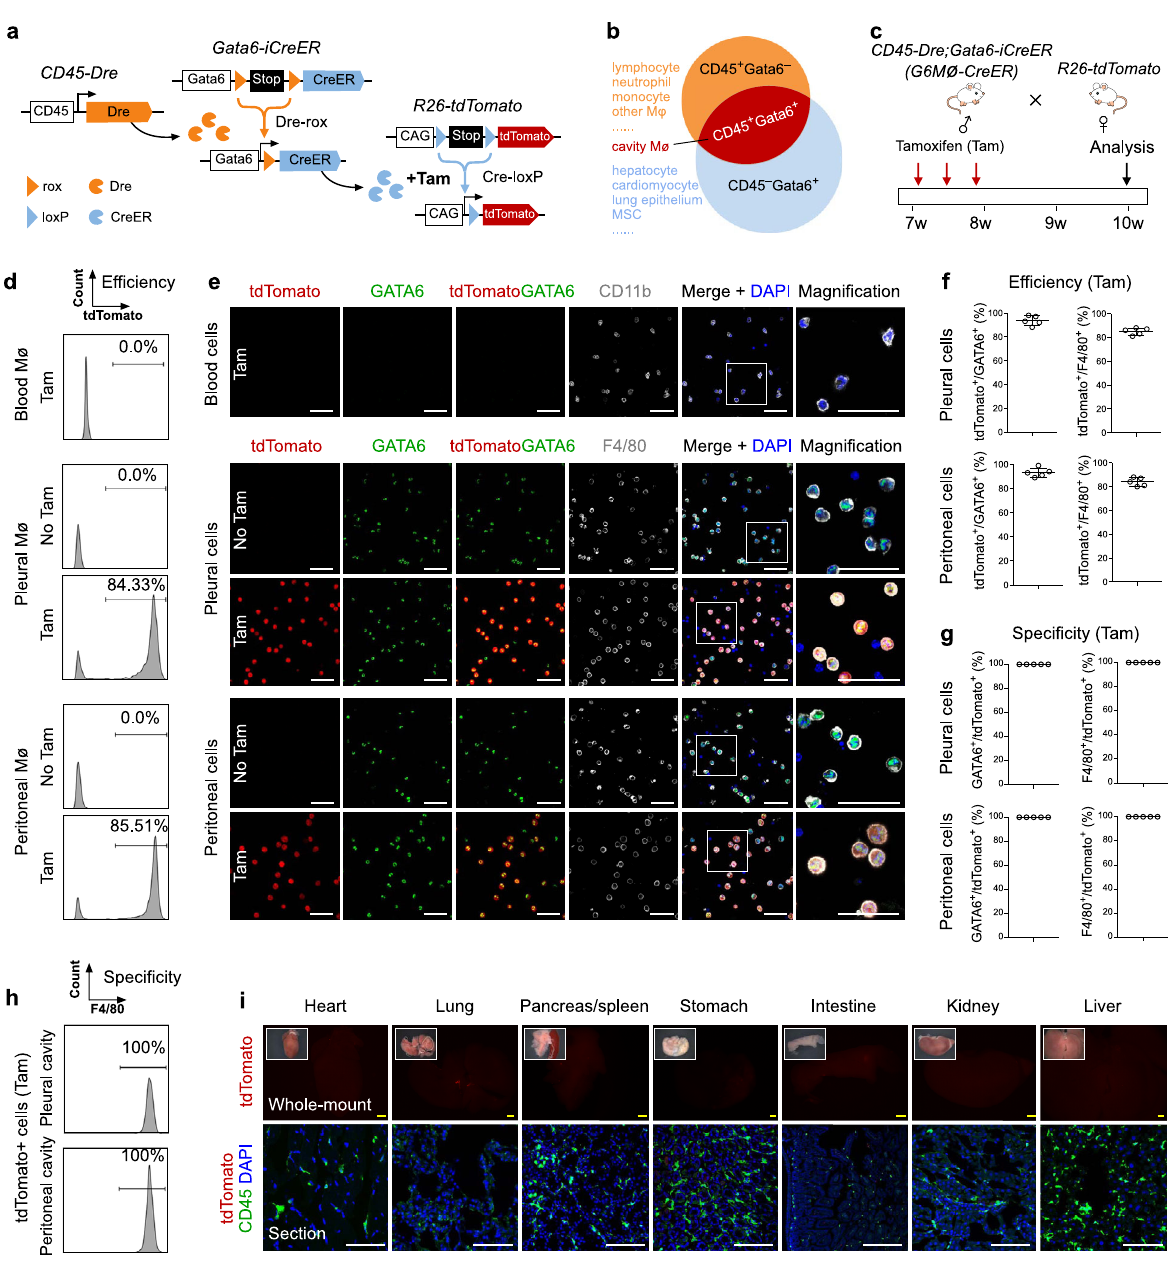
Fig. 1 Generation and characterization of a genetic system for speci fi c targeting of cavity macrophages. a Schematic fi gure showing CD45-Dre mediates Stop cassette removal from Gata6-iCreER and places CreER directly under Gata6 promoter. After tamoxifen (Tam), Cre-loxP recombination labels cells by tdTomato. b Intersectional genetics marks CD45 + GATA6 + cells as tdTomato + . c Schematic fi gure showing experimental design using cavity macrophage tracing tool CD45-Dre;Gata6-iCreER ( G6Mø-CreER ). d Flow cytometric analysis of the percentage of tdTomato + cells in macrophages from blood, pleural, and peritoneal cavity with or without Tam. e Immunostaining for tdTomato, CD11b, GATA6, F4/80 on dissociated cells from blood, pleural, or peritoneal cavity. Boxed regions are magni fi ed. f Quanti fi cation of the percentage of tdTomato + cells in GATA6 + or F4/80 + macrophages. Data are the mean ± SD; n = 5 mice per group. g Quanti fi cation of the percentage of GATA6 + or F4/80 + macrophages in tdTomato + cells. Data are the mean ± SD; n = 5 mice per group. h FACS showing the percentage of tdTomato + cells expressing F4/80. i Whole-mount epi fl uorescence images and immunostaining for CD45 and tdTomato shows no resident tdTomato + macrophages in visceral organs. Each image is representative of 5 individual biological samples. Scale bars, yellow, 1 mm; white, 100 µ m. Source data are provided as a Source Data fi